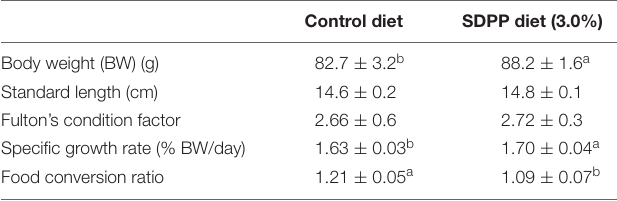
TABLE 2 | Somatic growth and feed efficiency in gilthead sea bream ( Sparus aurata ) fed diets containing spray-dried porcine plasma